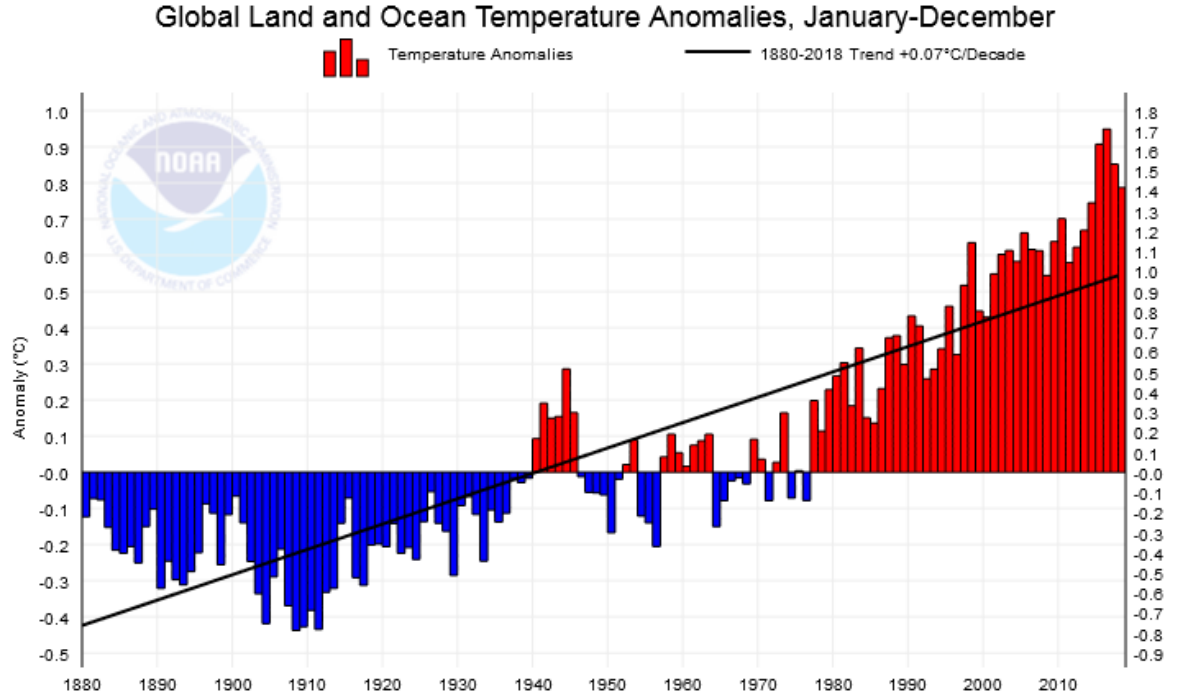
Figure 8. Graph of average annual global temperatures since 1880 compared to the long-term average (1901-2000). The zero line represents the long-term average temperature for the whole planet; blue and red bars show the difference above or below average for each year. Nation- al Oceanic & Atmospheric